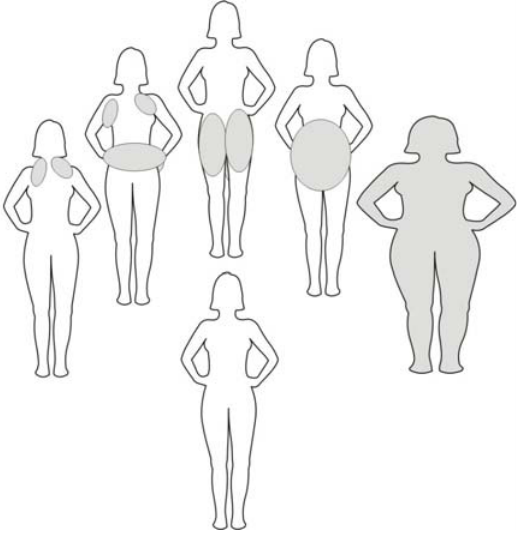
FIGURE 9 . Some individual variants of the sizes and locations of the fat storehouses in